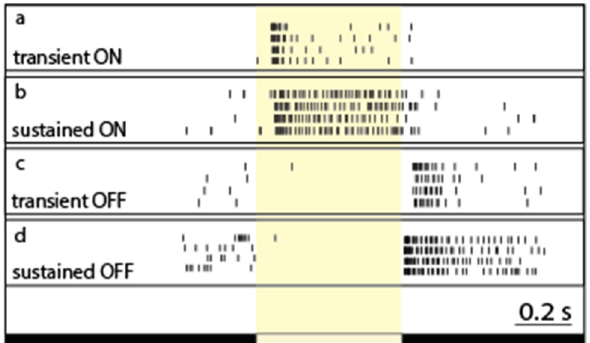
Figure 2. The diversity of response transience across the retinal ganglion cell population. Peri-event rasters of representative RGCs ( a – d ). Light-evoked spiking responses upon full-field illumination are rather similar across trials for each RGC, but they display a great variety in terms of their response length (or decay—expressed as the PSTH τ value in this work) for both the ON (cells 1 and 2) and OFF (cells 3 and 4) subpopulations. The white bar below the recordings represents the timing of the on- and off-set of the stimulus.